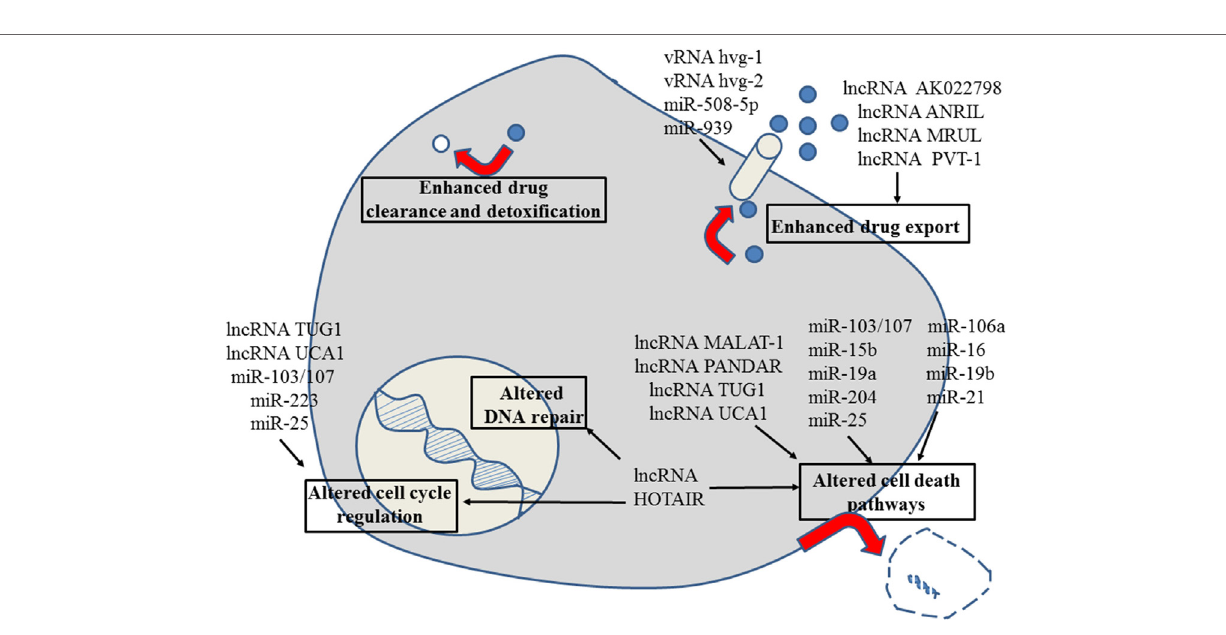
FiGURe 3 | Role of non-coding RNAs for the different reasons that can cause resistance to anticancer drugs in gastric cancer. For details about target genes and regulated protein expression by the non-coding RNAs, see text.